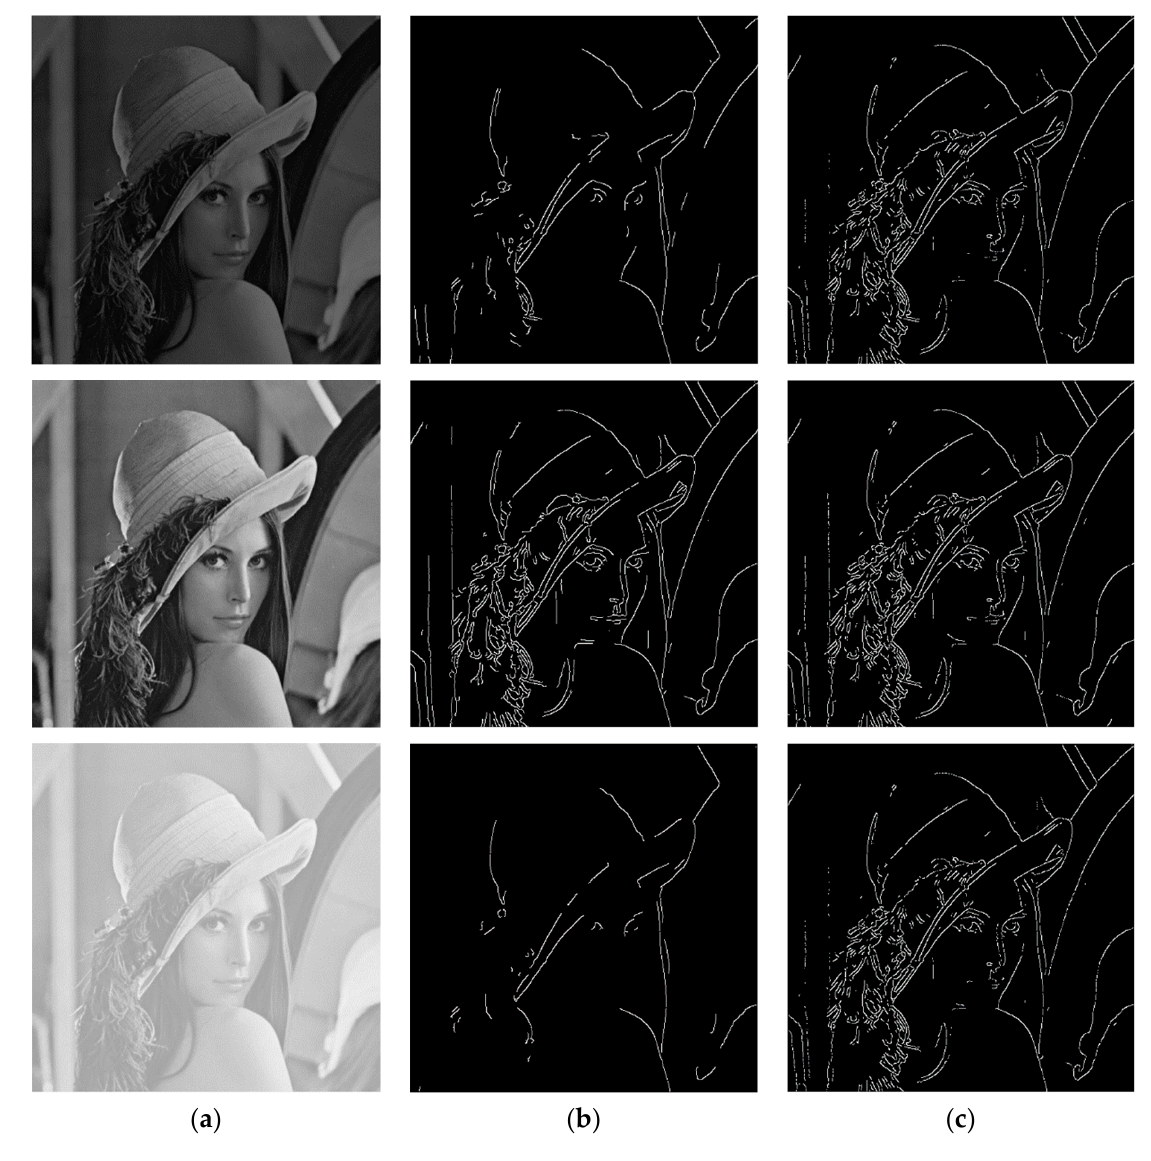
Figure 21. Edge map: ( a ) original image; ( b ) Canny edge detection with a fixed threshold; ( c ) proposed Canny edge detection. Table 2. Comparison of resource utilization and computation